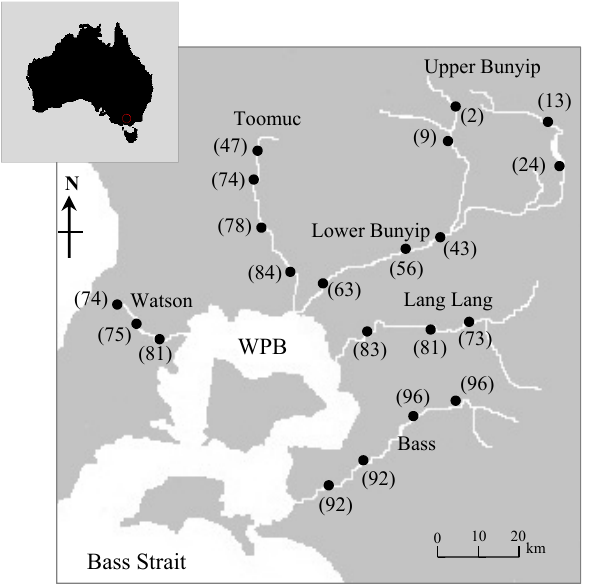
Figure 1. Map of Western Port Bay (WPB) in southern Victoria, Australia, and major rivers discharging into WPB. Closed circles represent sampling sites where surface water samples were ob- tained. Values in parentheses represent the % agriculture area in the